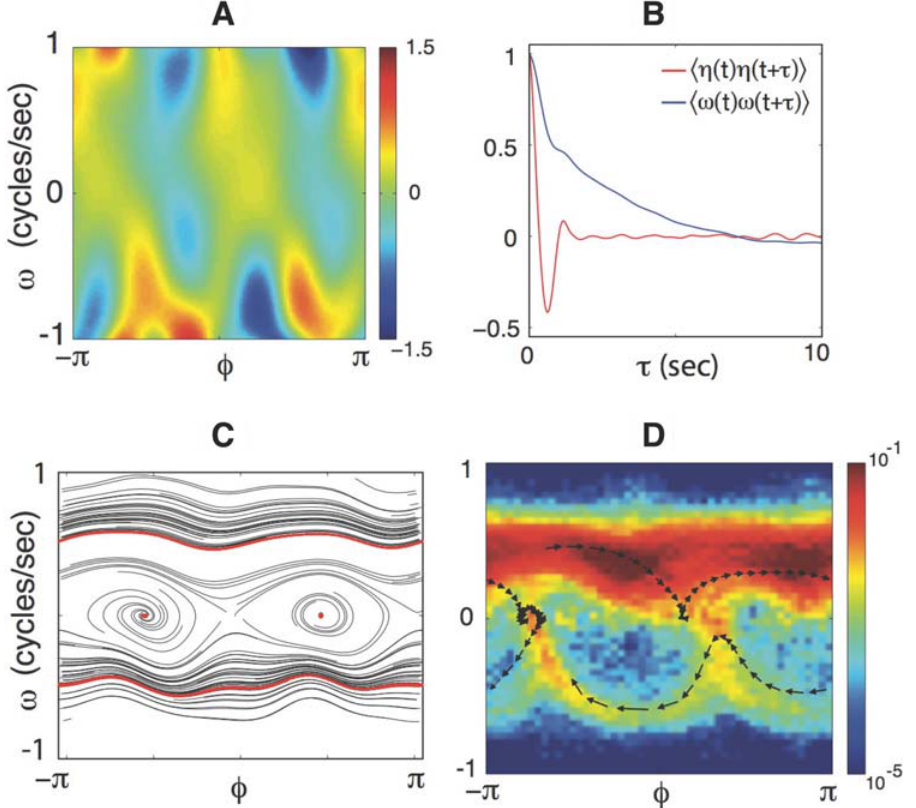
Figure 5. Reconstructing the phase dynamics. (A) The mean acceleration of the phase F ( v , w ) in Equation 4. (B) The correlation function of the noise Æ g ( t ) g ( t + t ) æ . The noise correlations are confined to short times relative to the phase velocity itself. (C) Trajectories in the deterministic dynamics. A selection of early-time trajectories is shown in black. At late times these same trajectories collapse to one of four attractors (red): forward and backward crawling and two pause states. (D) Joint density r ( v , w ) for worms sampled at 32 Hz. A sample trajectory of a single worm moving forwards, backwards, and pausing, is denoted by black arrows.